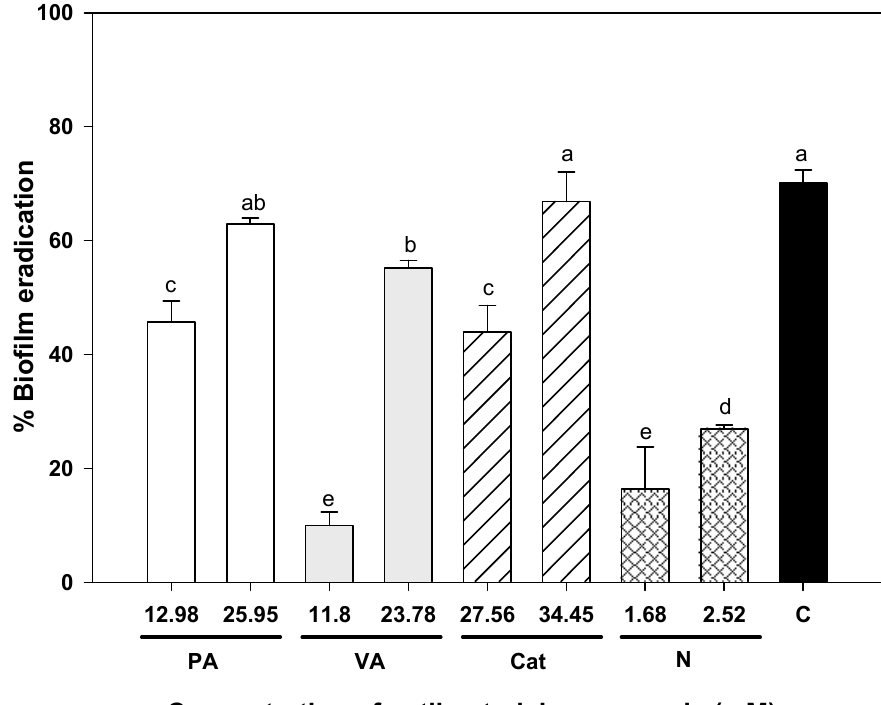
Figure 5. Percentage of eradication of pre-formed uropathogenic E. coli biofilms incubated for 24 h at 37 °C and exposed to single and combined presence of phenolic compounds for 1 h. Means for three independent experiments ± deviation standard are illustrated. PA = protocatechuic acid, VA = vanillic acid, Cat = catechin, N = nitrofurantoin, C = Combination (1.62 mM protocatechuic acid, 0.74 mM vanillic acid and 0.05 mM catechin). Different letters indicate significant differences among treatments ( p ≤ 0.05).